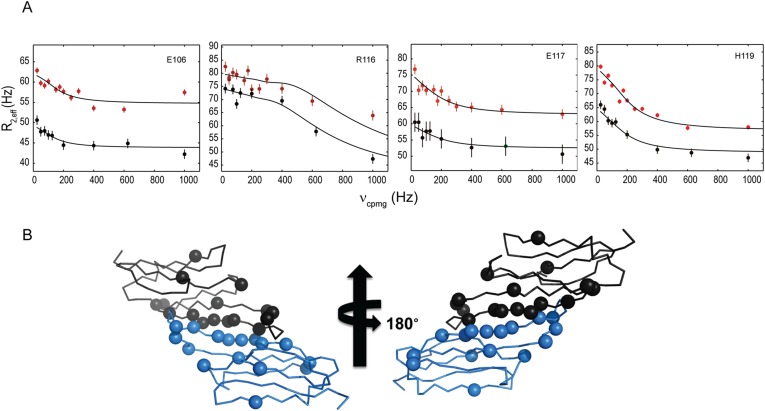
15N-CPMG relaxation dispersion experiments detect dimer-to-monomer exchange.(A) Relaxation dispersion measurements reveal a two-state transition. Representative relaxation dispersion curves of 15N transverse relaxation rate (R2,eff) plotted as a function of field strength, (νCPMG) are shown (see Materials and methods for details). Data were recorded at static field strengths of 800 MHz (red) and 600 MHz (black) at pH 7.5 and 22°C. Values of kex, δω, and pb were extracted using the program, GUARDD. (B) Backbone representation of HSPB5-ACD dimer is shown with the Cα atoms of exchanging residues that are well fit by a two-state model shown as spheres. Resonances showing relaxation rates in the range 760 s−1 to 1119 s−1 occur mainly at the dimer interface and in Loop 5/6.DOI:
http://dx.doi.org/10.7554/eLife.07304.00810.7554/eLife.07304.009Figure 2—source data 1.Parameters from relaxation dispersion experiments performed on 0.7 mM HSPB5-ACD at 22°C and pH 7.5.